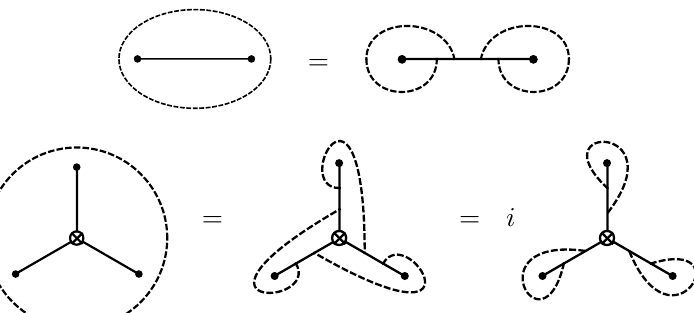
Figure 50 . The action of b X (cid:0) on b + ; b (cid:0) 2 H Y .